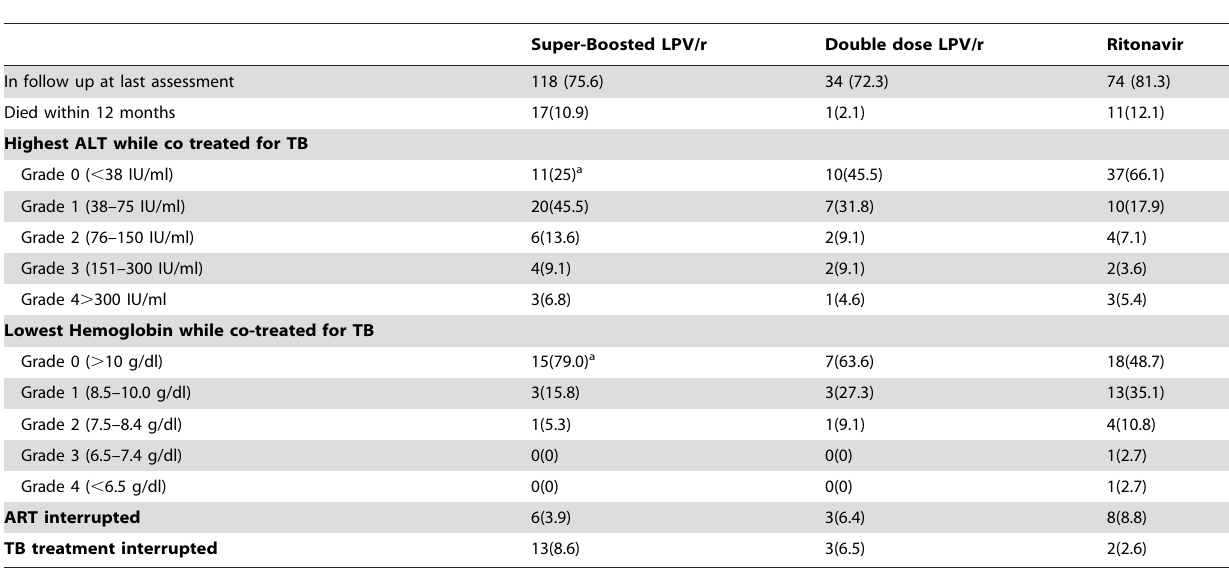
Table 3. Toxicity outcomes during 12 months after initiation of TB co-treatment by modification made to the PI-containing